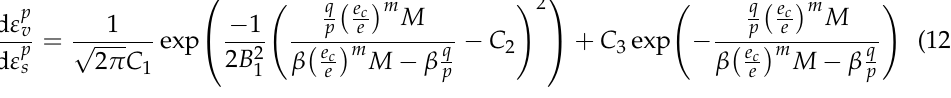
Substituting Equation (11) into Equation (9) yields the flow rule on the stress-dilatancy